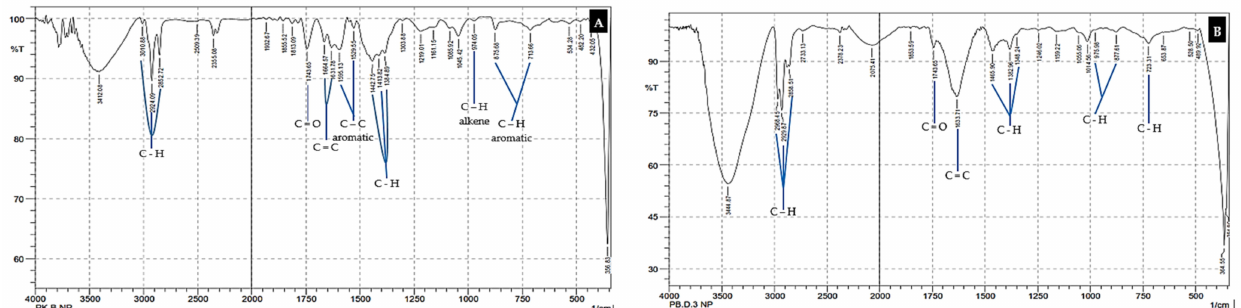
Figure 5. Identification of the type of MP pollutant in each sample based on the FTIR chromatogram. ( A ) Marine water samples; ( B ) fish